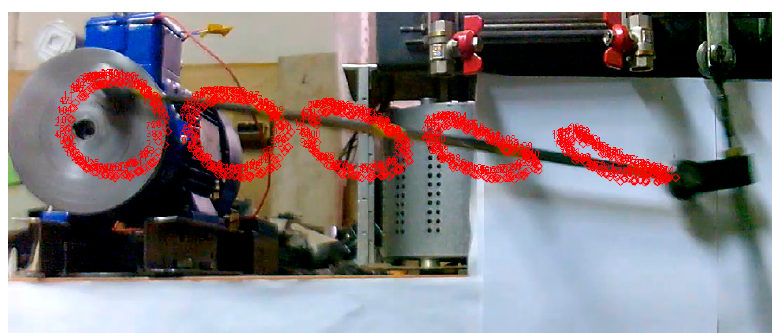
Figure 7. Recording the successive positions of the markers .